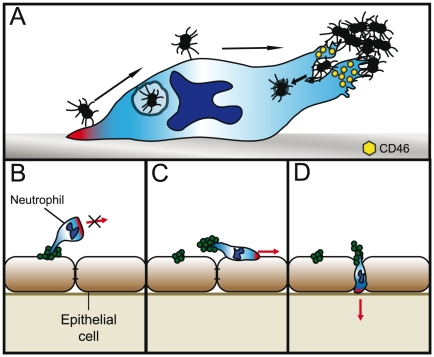
A schematic illustration of bacteria hitchhiking on PMNs.(A) Bacterial adherence to PMNs occurs either by direct uropod contact or by transport on the plasma membrane from the pseudopod. Although initial contact was made with the pseudopod, PMNs ended up bound to the microcolony via their uropod. The binding recruits CD46 and bacteria can be internalized via the uropod. (B) The PMN can be immobilized and trapped by a microcolony that is bound to both an epithelial cell and a uropod or (C) the PMN can remove the microcolony from the epithelial cell and transport it away from the site. (D) The nature of PMNs allows them to easily migrate under and in between epithelial cells. In this manner, bacteria can hitchhike on the uropod to penetrate the epithelial barrier.